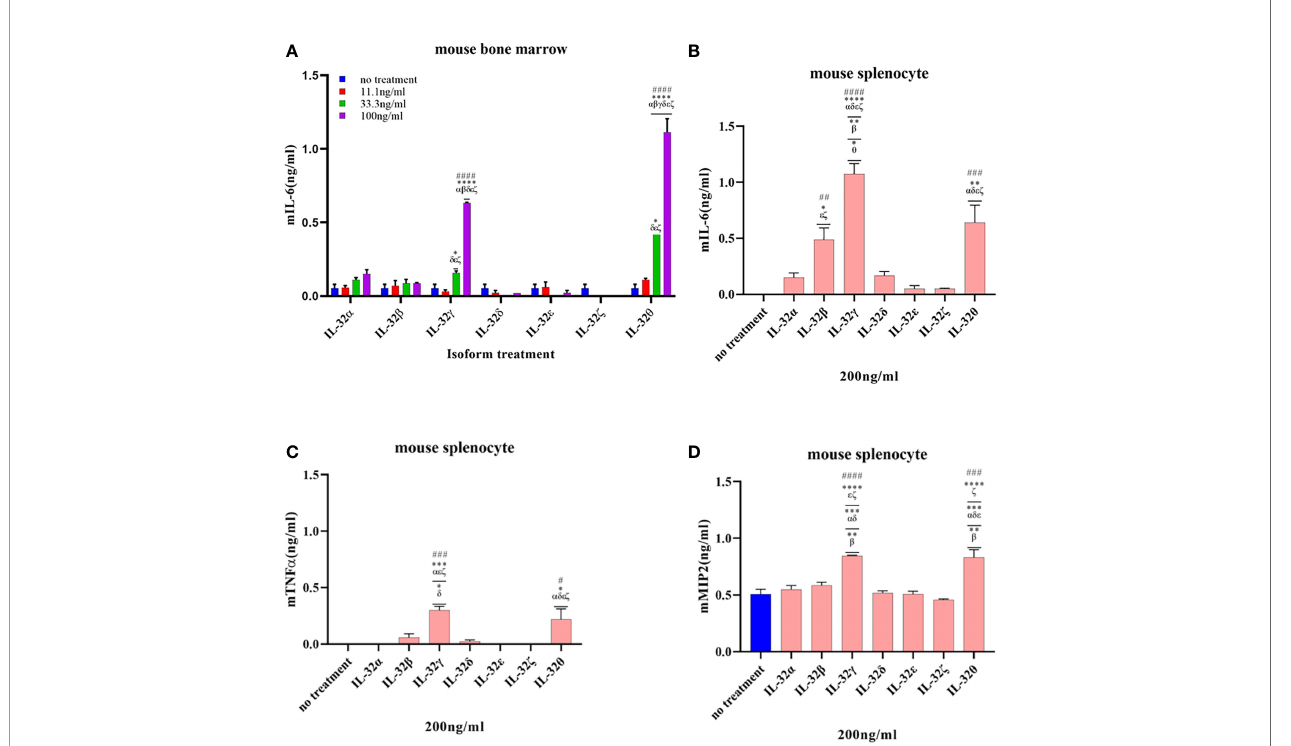
FIGURE 5 | Biological activities of seven rIL-32 isoforms in the primary mouse immune cells. rIL-32 isoforms with different concentrations were treated for 18 h in mouse bone marrow. The level of IL-6 was measured by ELISA (A) , and 200 ng/ml of each isoform was treated for 18 h in mouse splenocytes. The levels of IL-6, TNF a , and MIP2 were measured by ELISA [ (B – D) , respectively]. The bar graph represents the level of cytokines, mean ± SEM. Statistical testing was performed using two-way ANOVA (A) and one-way ANOVA (B – D) , followed by Tukey ’ s post-hoc analysis. # p < 0.05, ## p < 0.01, ### p < 0.001, #### p < 0.0001 as compared to the no-treatment control within the same isoform treatment. * p < 0.05, ** p < 0.01, *** p < 0.001, **** p < 0.0001 as compared to other displayed isoform symbols treated with the same